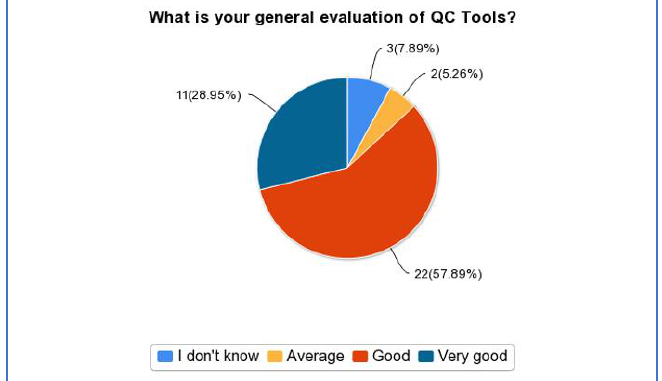
Figure 19. Customer satisfaction survey on QC Tools: general evaluation. A percentage larger than 86% of the survey respondents provide a general evaluation of the application as “good” or “very good” (more details in [6] ).